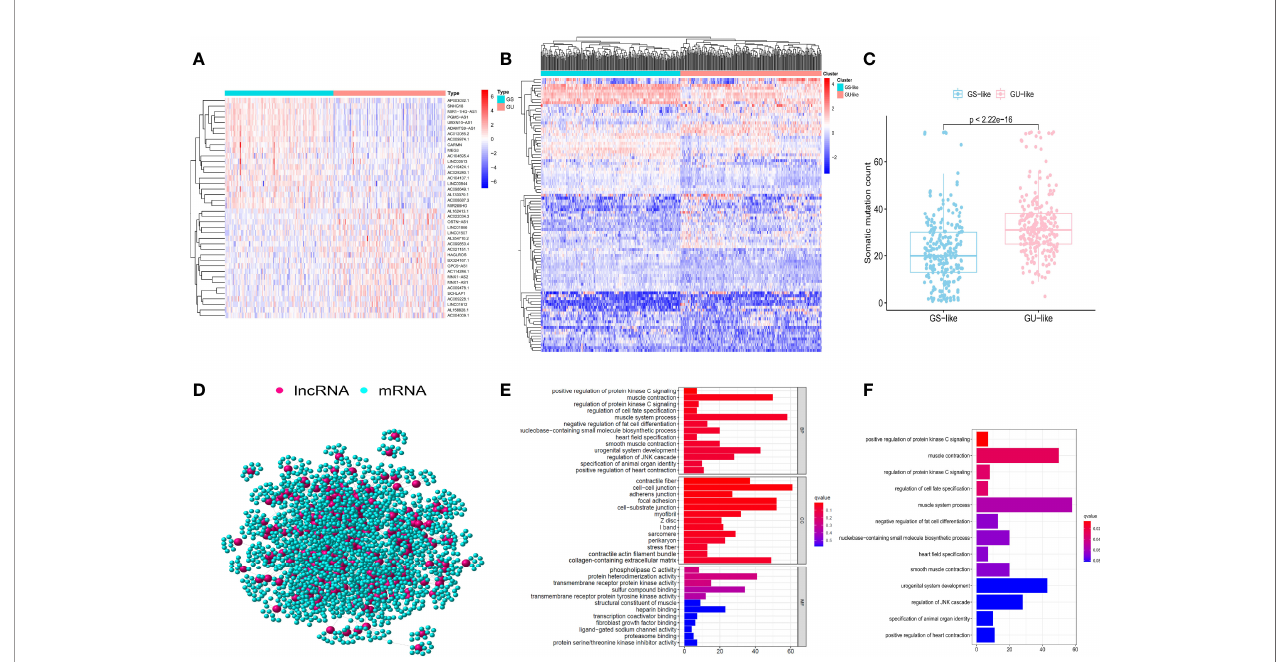
FIGURE 1 | Identi fi cation and functional analysis of genomic instability-associated long non-coding RNAs (lncRNAs) in patients with prostate cancer (PCa). (A) 50 of the 95 signi fi cantly differentially expressed lncRNAs between the genomic unstable (GU) group and the genomic stable (GS) group. The left blue part is the GS-like group, and the right red part is the GU-like group. (B) Clustering of 488 PCa samples based on the expression pro fi les of 95 candidate genomic instability- associated lncRNAs. The left blue cluster is the GS-like group, and the right red cluster is the GU-like group. (C) Boxplots of somatic mutation count in the GU-like group and the GS-like group. (D) Co-expression network of genomic instability-associated lncRNAs and mRNAs. The red circles represent lncRNAs, and the blue circles represent mRNAs. GO (E) and KEGG (F) functional enrichment analyses for mRNAs co-expressing